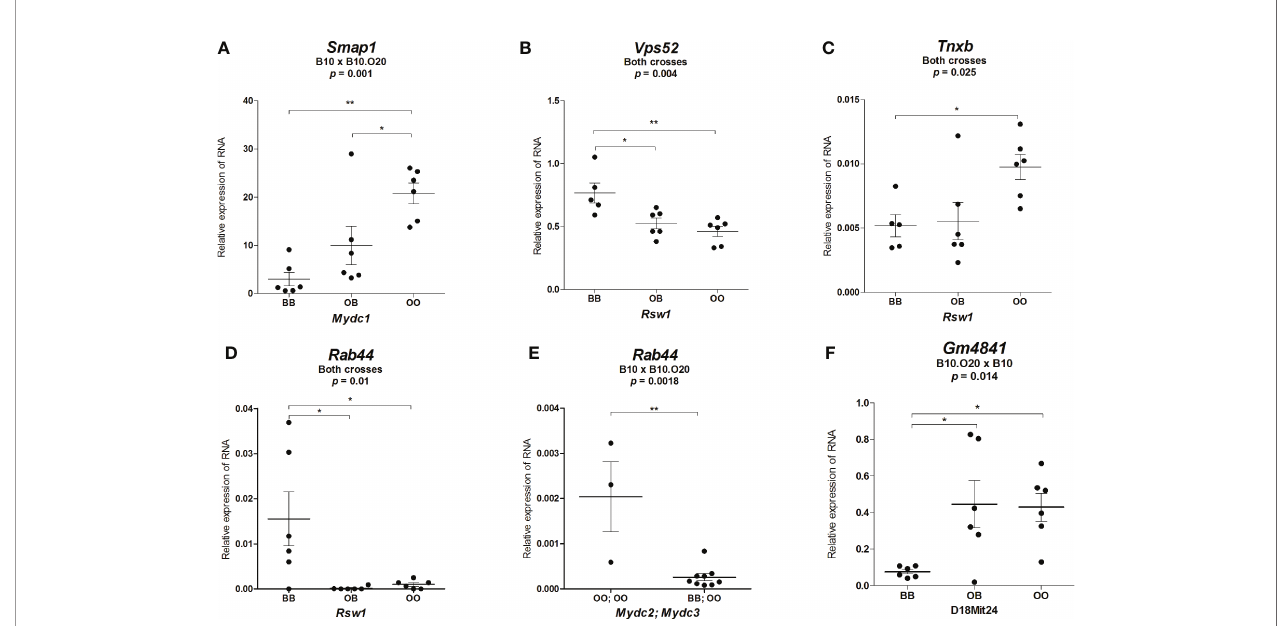
FIGURE 9 | Expression of mRNA of potential candidate genes in spleens of F 2 mice. Relative expression of a target gene versus a reference gene Gapdh is shown. Only genes with signi fi cant differential expression are presented. (A) Relative expression of Smap1 RNA in mice carrying different alleles of Mydc1 (chr.1). (B) Relative expression of Vps52 , (C) Tnxb , and (D) Rab44 RNA in mice carrying different alleles of Rsw1 . (E) Relative expression of Rab44 RNA in combined genotypes of Mydc2 (linked with rs78065633 – chr.15) and Mydc3 (linked with D17Mit197) corresponding to the lowest (BB; OO) and highest (OO; OO) frequency of CD11b + Gr1 + and neutrophils (Gr1 + Siglec-F - cells from CD11b + cells) in the cross B10xB10.O20. (F) Relative expression of Gm4841 RNA in mice carrying different alleles of D18Mit24. Statistical analysis was performed in (A – D, F) by ANOVA followed by Bonferroni multiple comparison test or in (E) by two-tailed unpaired t -test. p-values are as indicated. Bars represent the average ± SEM. * p < 0.05; ** p <